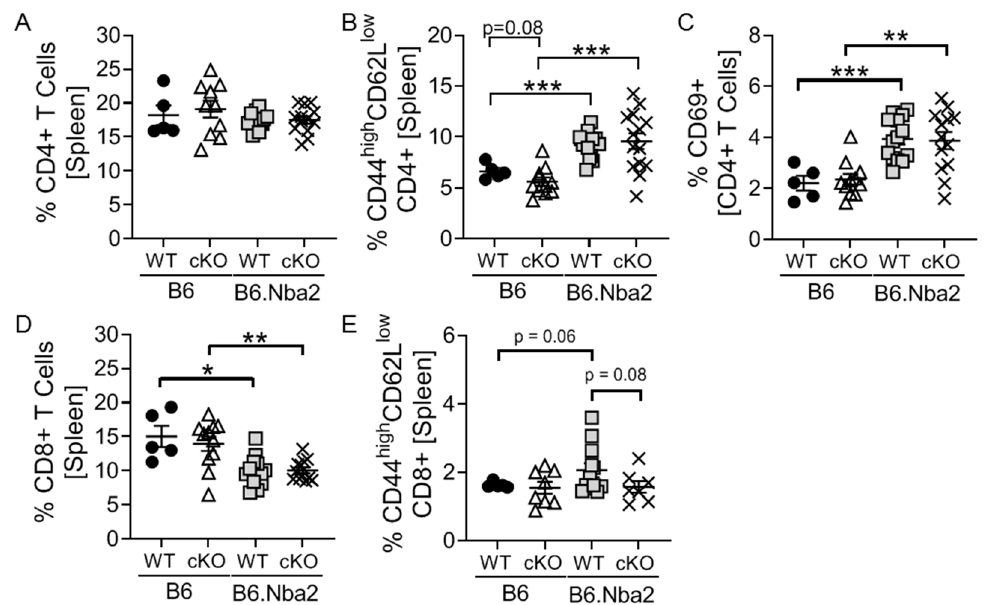
Figure 1. Dysregulated CD4+ and CD8+ in B6.Nba2 mice are independent of T-cell intrinsic IFNAR expression. IFNAR-sufficient and -deficient female B6 and B6.Nba2 mice were analyzed for frequencies of CD4+ and CD8+ cells at 4 months of age by flow cytometry. ( A ) Total splenic CD4+ T cells, ( B ) CD44highCD62Llow effector/memory CD4+ T cells, ( C ) CD69+ recently activated CD4+ T cells, ( D ) Total CD8+ T cells, ( E ) CD44highCD62Llow effector/memory CD8+ T cells. Each symbol represent one mouse. n = 5 (B6), n = 11 (B6 cKO), n = 14 (B6.Nba2), n = 9 (B6.Nba2 cKO). * p < 0.05; ** p < 0.01; *** p < 0.001, Student’s unpaired t -test with Welch’s correction.